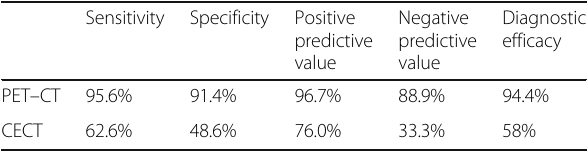
Table 5 Diagnostic performance of PET/CT in comparison with CECT by regional lesion-based